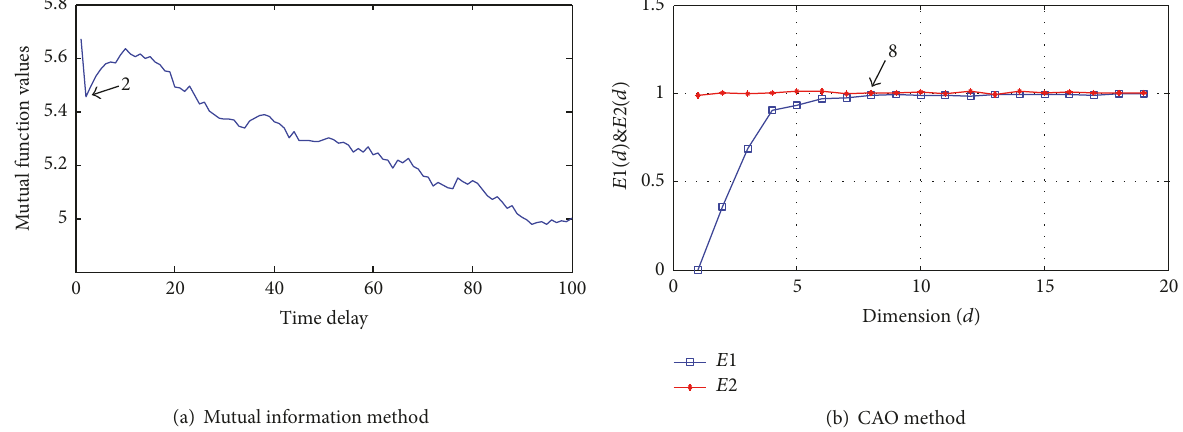
Figure 13: Delay time and the embedded dimension of phase space reconstruction.